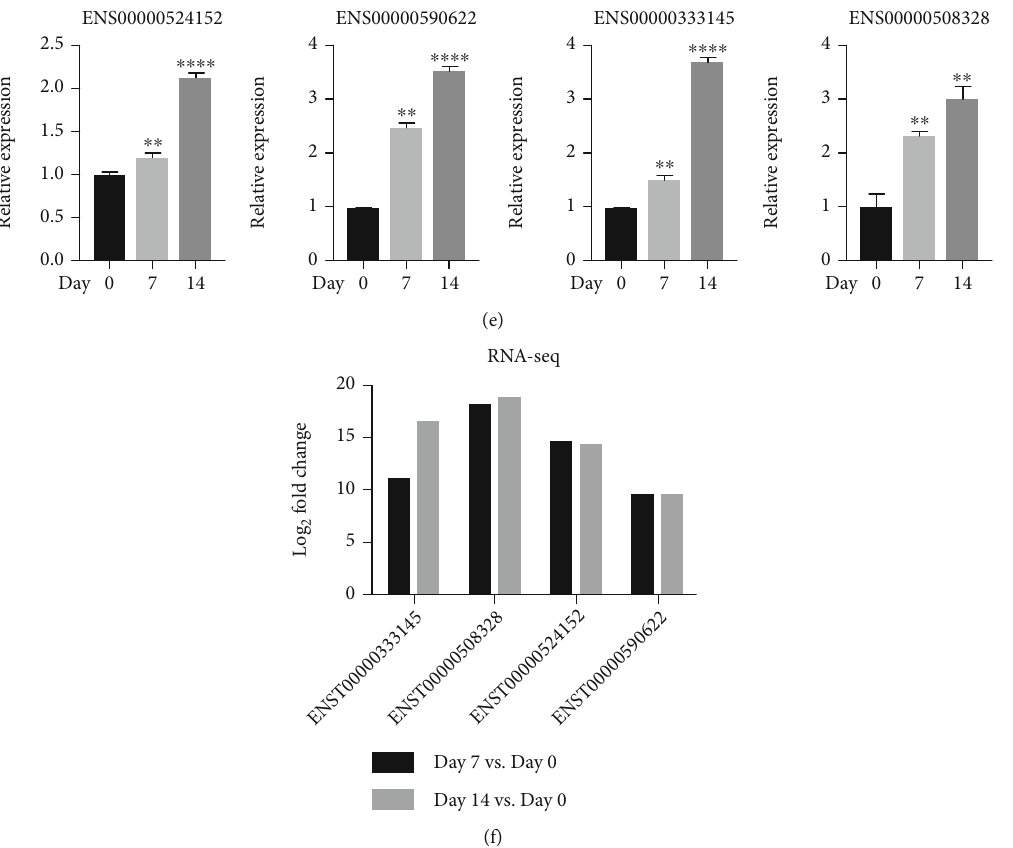
Figure 2: lncRNA and mRNA pro fi les of stem cells from human exfoliated deciduous teeth (SHED) during odontogenic di ff erentiation. (a) Volcano plot showing 569 lncRNAs upregulated and 569 lncRNAs signi fi cantly downregulated on day 7, and 767 lncRNAs upregulated and 591 lncRNAs signi fi cantly downregulated on day 14 ( Log2 foldchange ð FC Þ > 1 : 3 or ≤ -1.3, p < 0 : 05 ). The Venn diagram shows di ff erentially expressed lncRNAs during odontogenic di ff erentiation of SHED. (b) Volcano plot showing 343 mRNAs upregulated and 219 mRNAs downregulated on day 7, and 437 mRNAs upregulated and 323 mRNAs downregulated on day 14 ( Log2fold change ð FC Þ > 1 : 3 or ≤ -1.3, p < 0 : 05 ) on gene level. The Venn diagram shows di ff erentially expressed mRNAs during odontogenic di ff erentiation of SHED. (c) Gene Ontology (GO) analysis of mRNAs di ff erentially expressed during odontogenic di ff erentiation in SHED on day 7. (d) GO analysis of mRNAs di ff erentially expressed during odontogenic di ff erentiation in SHED on day 14. (e) qRT-RCR validation of selected lncRNAs di ff erentially expressed during odontogenic di ff erentiation: ENST00000333145, ENST00000508328, ENST00000524152, and ENST0000 0590622. (f) Results of RNA-sequencing data for selected lncRNAs. Data were expressed as the mean ± standard deviation (SD) of three